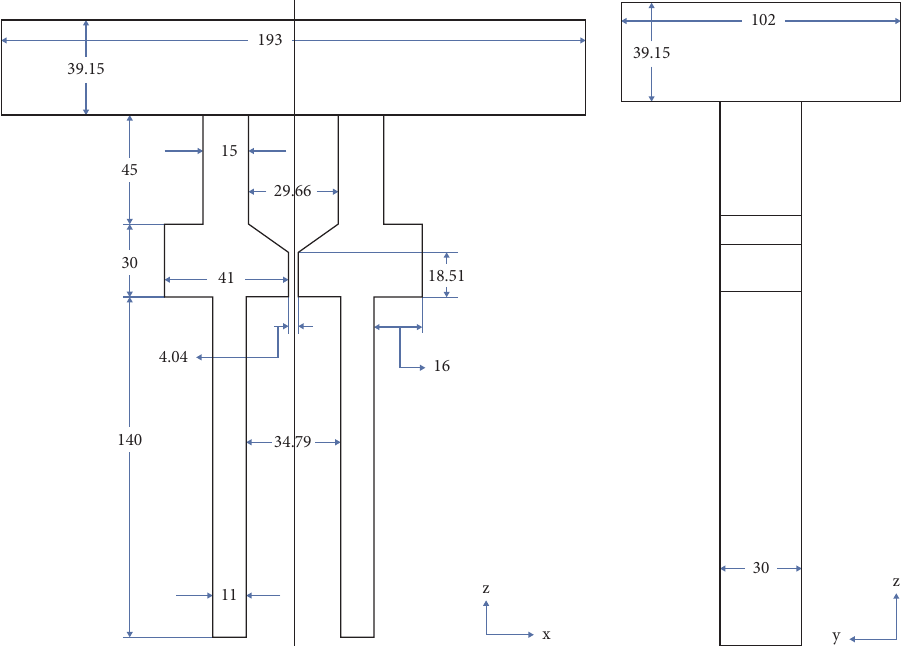
Figure 6: Laboratory sample size in two side